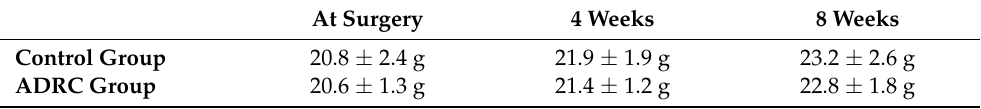
Table 2. Mean body weight (g) of mice in the control and ADRC groups at the indicated time points. At